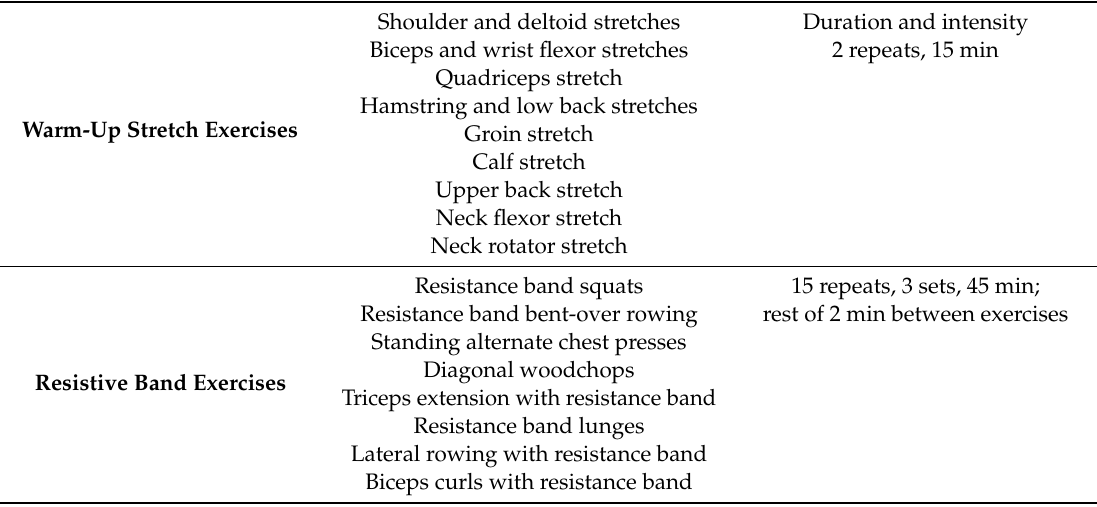
Table 1. The exercise